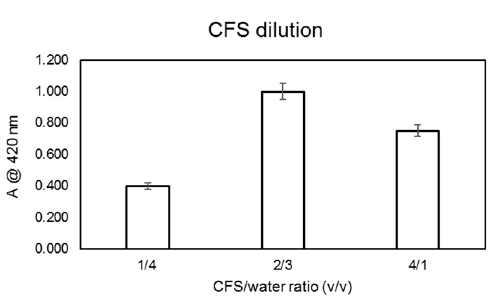
Figure 3. AgNPs yields’ dependence on the CFS/water dilution ratio. Experiments were carried out using the CFS from the SAMU strain at 80 °C and after 24 h of incubation. The formation of silver NPs was monitored by measuring the solutions’ absorbance at 420 nm.